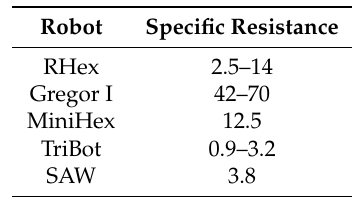
Table 1. Specific